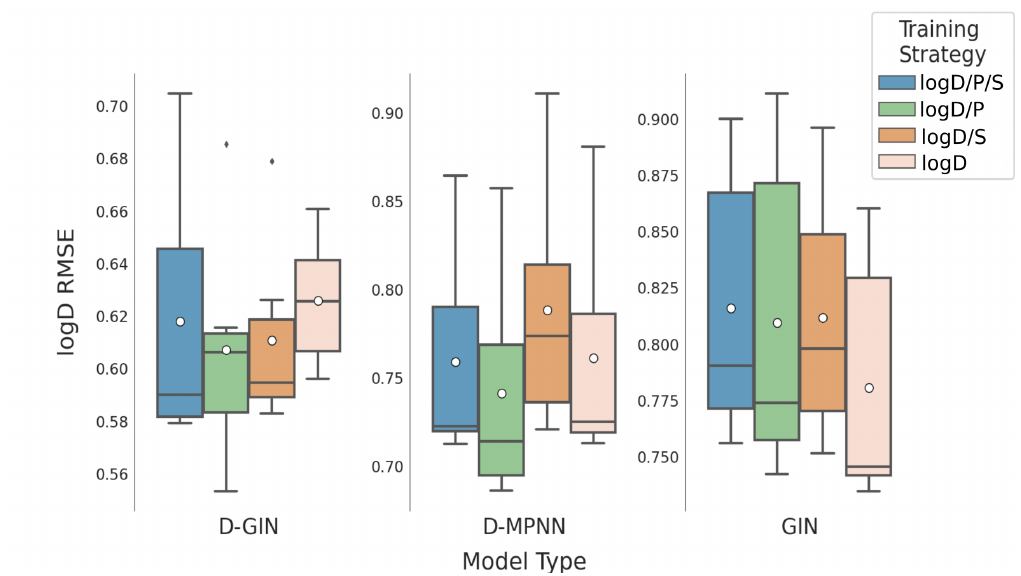
Figure 7. LogD prediction results for all GNN model types according to the used training strategy. Blue box shows the performance of the multi-task training strategy using logD, logS, and logP. The green and orange box show the results utilizing a combination of logD and logP and logD and logS for training. The salmon pink box shows the results using logD for training. The mean is shown as a white dot whereas the median is shown as a dark gray line. Exact values are listed in Tables A8–A11 in the Appendix